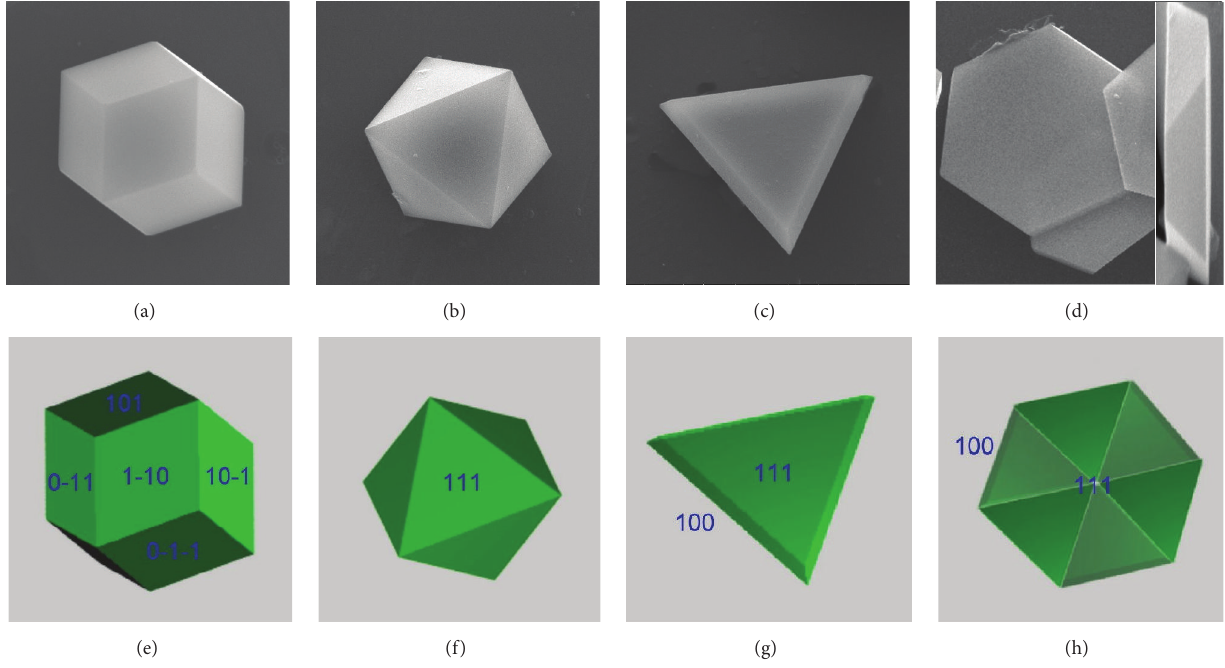
Figure 7: The typical morphologies in our work and sketches of the corresponding crystal